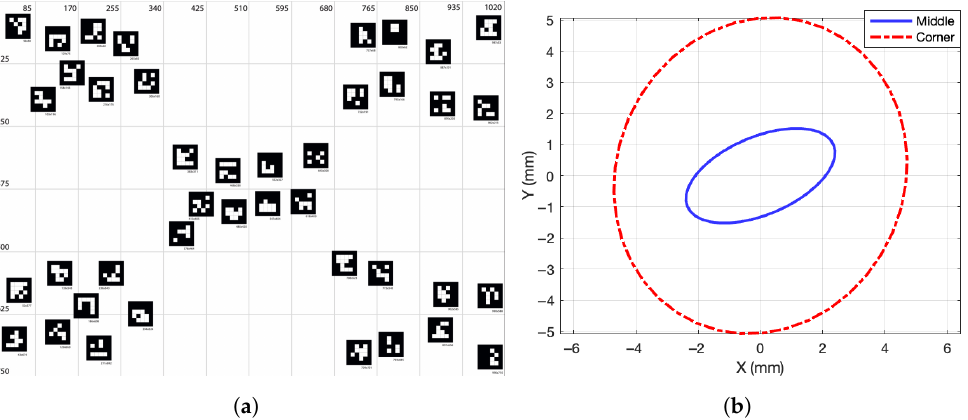
Figure 10. ( a ) Aruco markers plane for accuracy checking; ( b ) Ellipses of uncertainty in position (95% confidence level with k = 2.4478